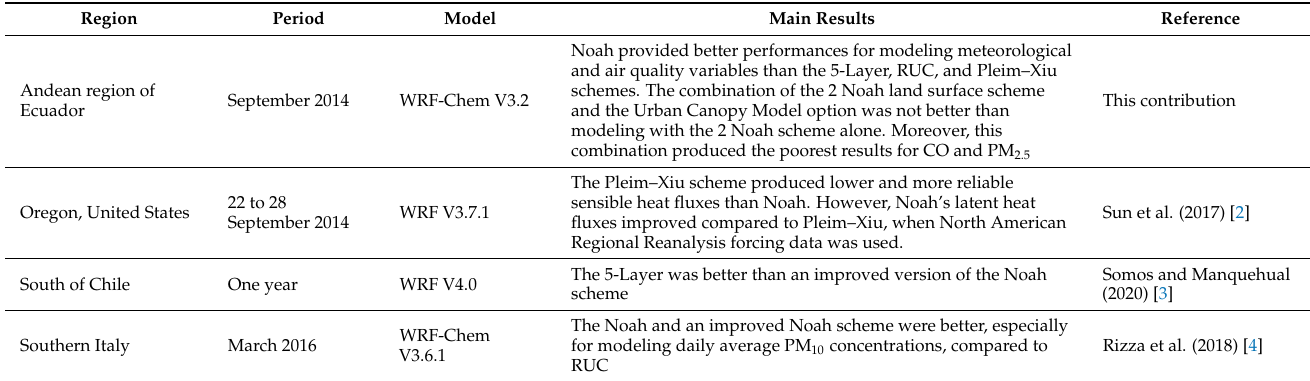
Table 9. Comparison with other assessments on the influence of land surface